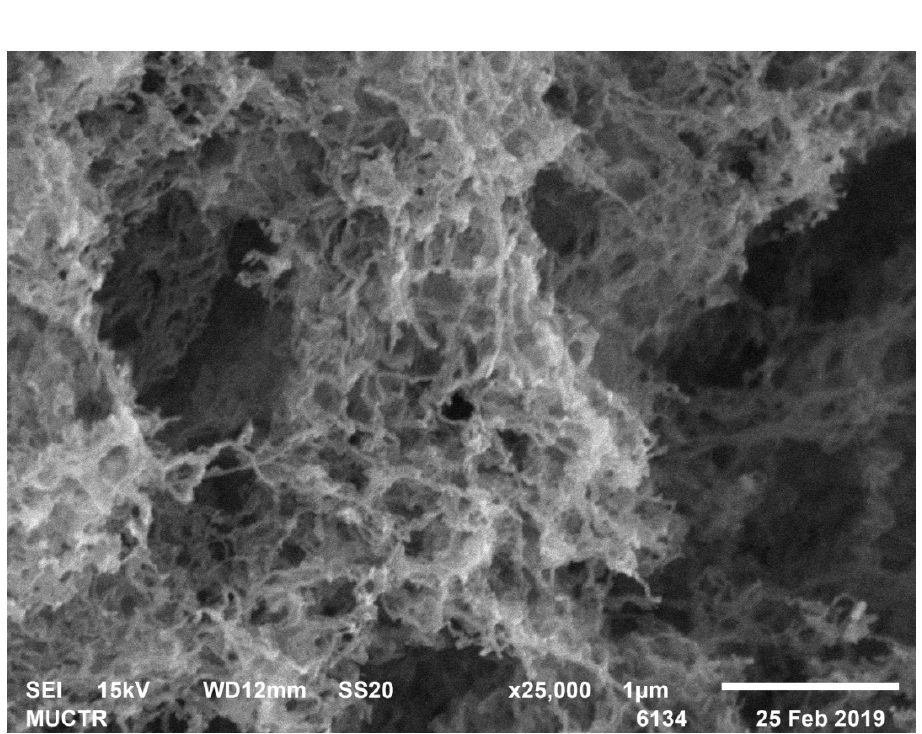
Figure 4. SEM-image of sample 2 chitosan-based aerogel particles.